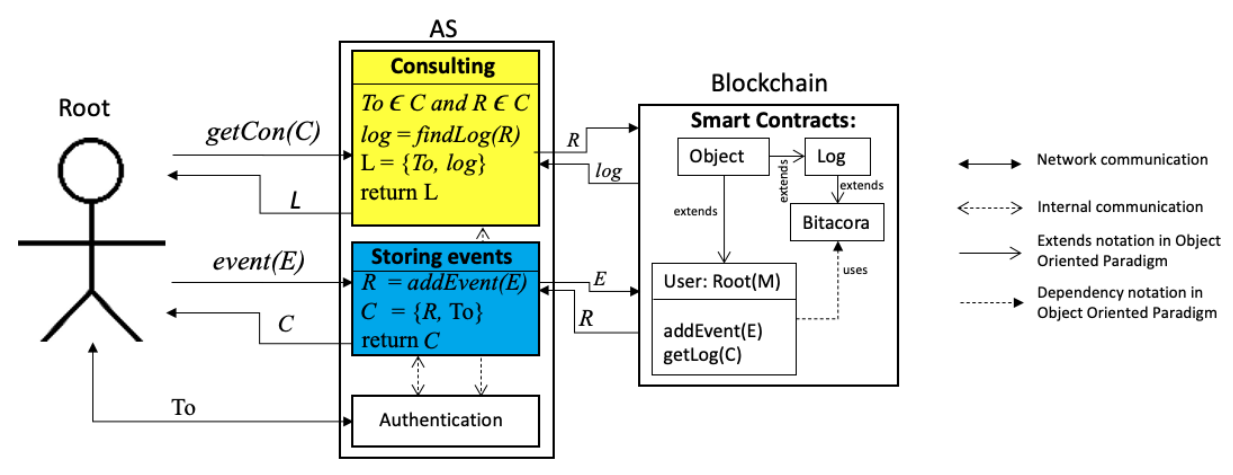
Figure 4. Consulting and storing